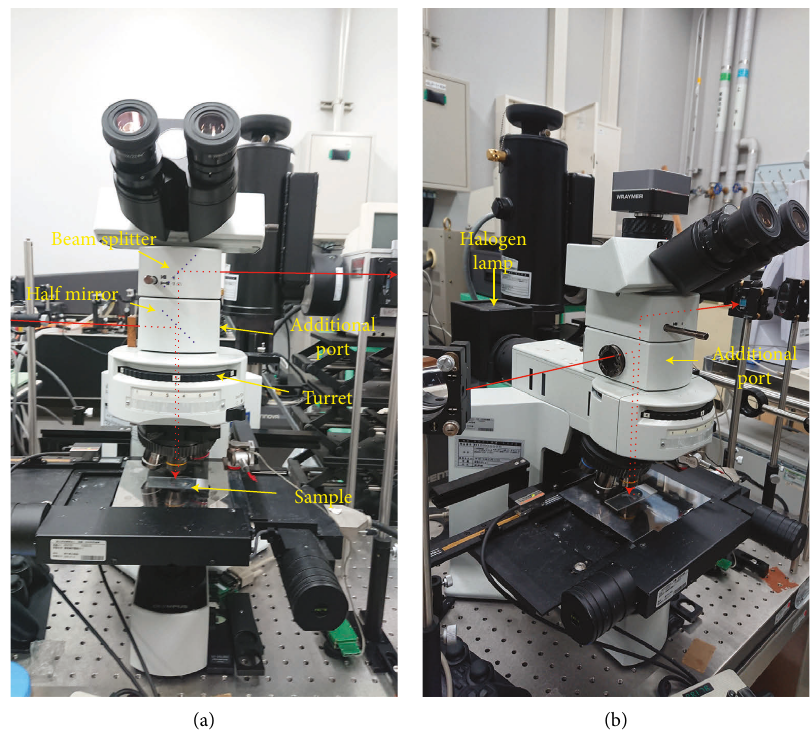
Figure 2: Photographs of the microscope part of the apparatus. Front view (a) and side view (b). The red line represents the path of the laser beam and the scattering. The laser beam introduced into the microscope is directed to the sample by the half mirror mounted in the additional port. The scattering from the sample is passed through the half mirror and extracted from the microscope by the beam